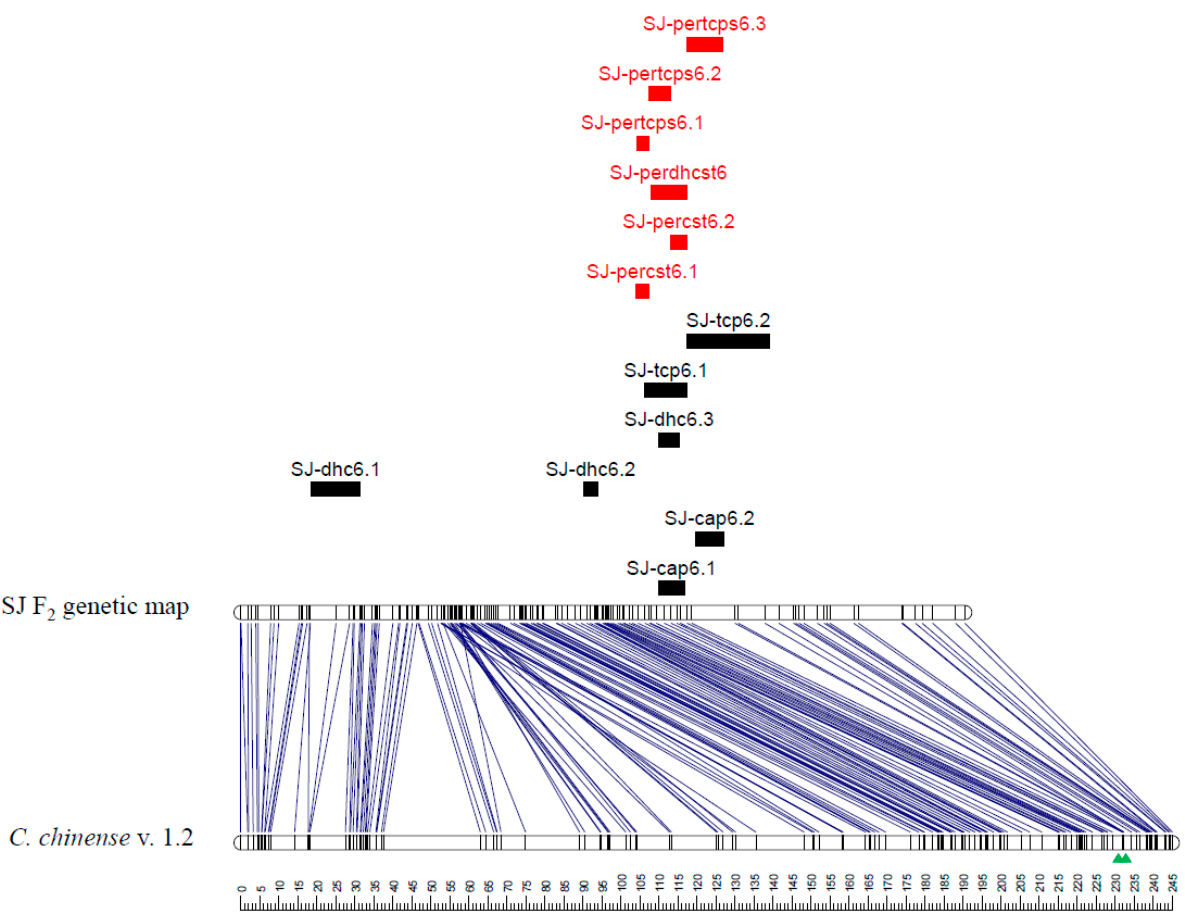
Figure 2. ‘SJ’ F 2 linkage map of chromosome 6 containing QTLs related to the capsaicinoid and capsinoid contents in the pericarp. Red and black bars indicate QTLs for capsinoids and capsaicinoids, respectively. Blue lines indicate overlapping bin markers on the genetic map and C. chinense scaffold v. 1.2. The two green triangles below the physical map indicate the region of SNP markers based on the QTLs for capsaicinoids.